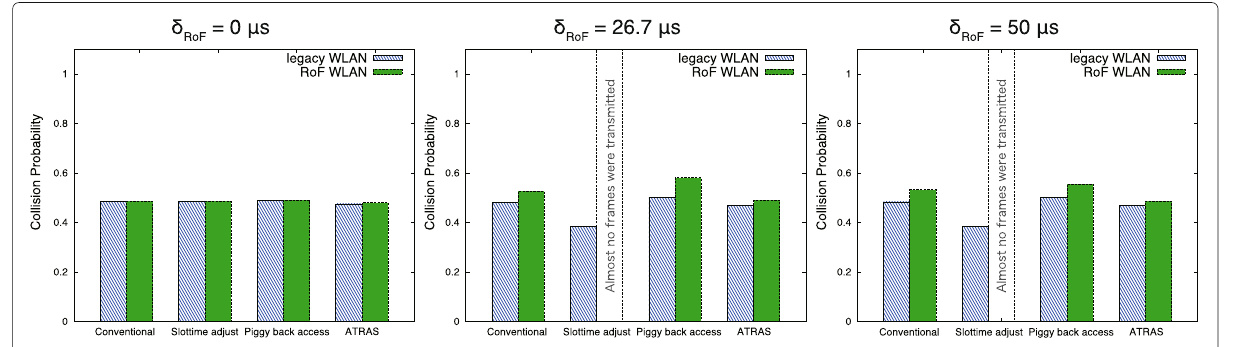
Fig. 9 Collision probability of the RoF WLAN and legacy WLAN when α = 1